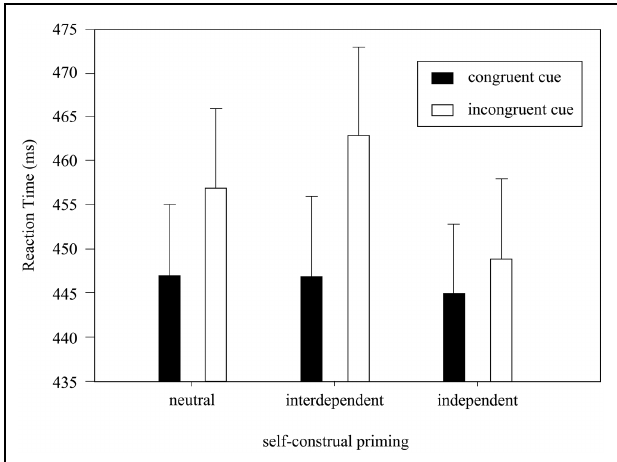
FIGURE 3 | The mean RTs by Cue Congruency and Priming. Error bar indicates SEM.